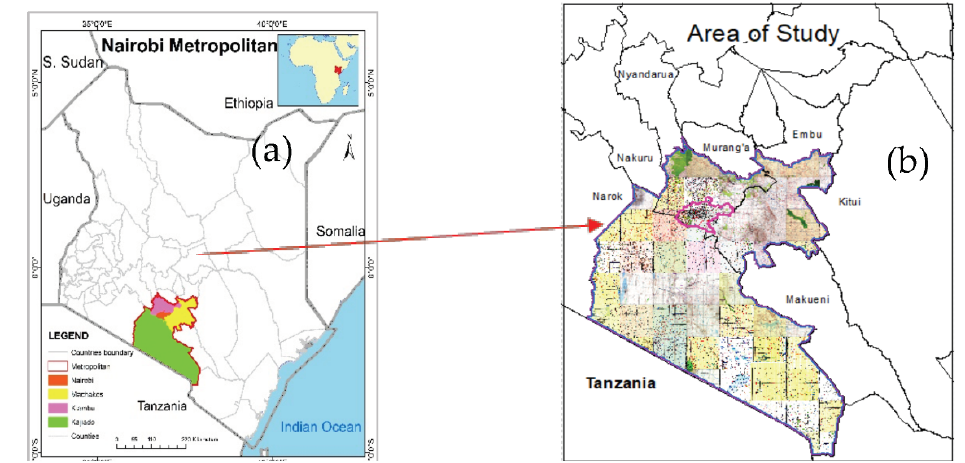
Figure 1. ( a ) Location of Nairobi Metropolitan with respect to Kenya; ( b ) location of Nairobi City County with respect to the study area of Nairobi Metropolitan.